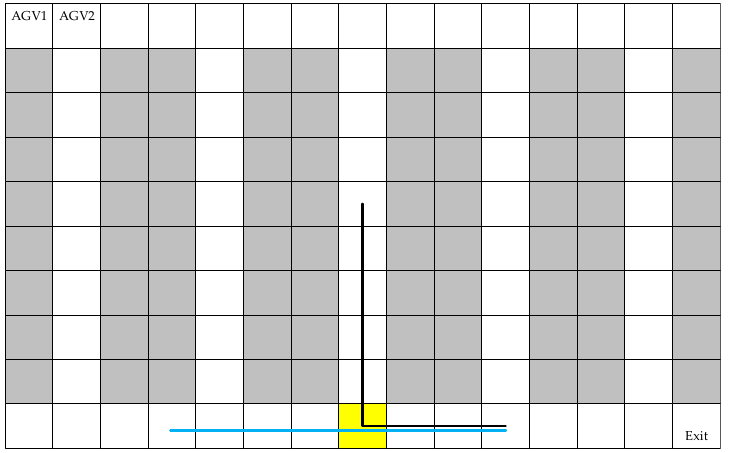
Figure 5. Uniform direction conflict when two AGVs meet at the yellow cell and are arranged to go to right.